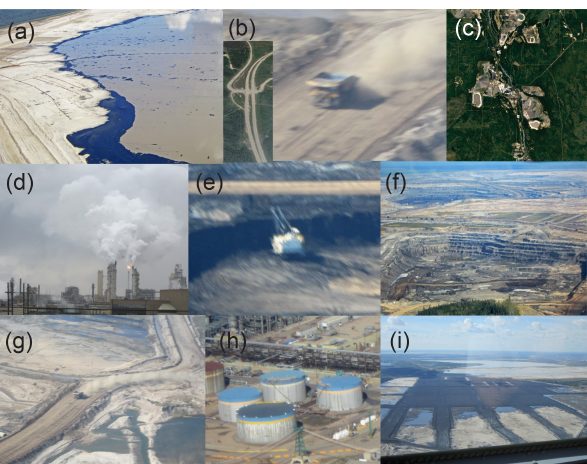
Figure 4. Images of likely sources associated with each of the prin- cipal components. (a) Wet tailing ponds (component 1). (b) Mine truck fleet and highway traffic emissions (component 2). (c) Bio- genic emissions from vegetation (component 3). (d) Upgrader facil- ities (component 4). (e) Exposed bitumen on mined surfaces (com- ponent 5). (f) Fugitive greenhouse gas emissions from mine faces (component 6). (g) Windblown dust from exposed sand (compo- nent 7). (h) Fugitive emissions of ammonia from storage tanks (component 8). (i) Composite (dry) tailings (component 10). No image is shown for production CO from oxidation of VOCs (com- ponent